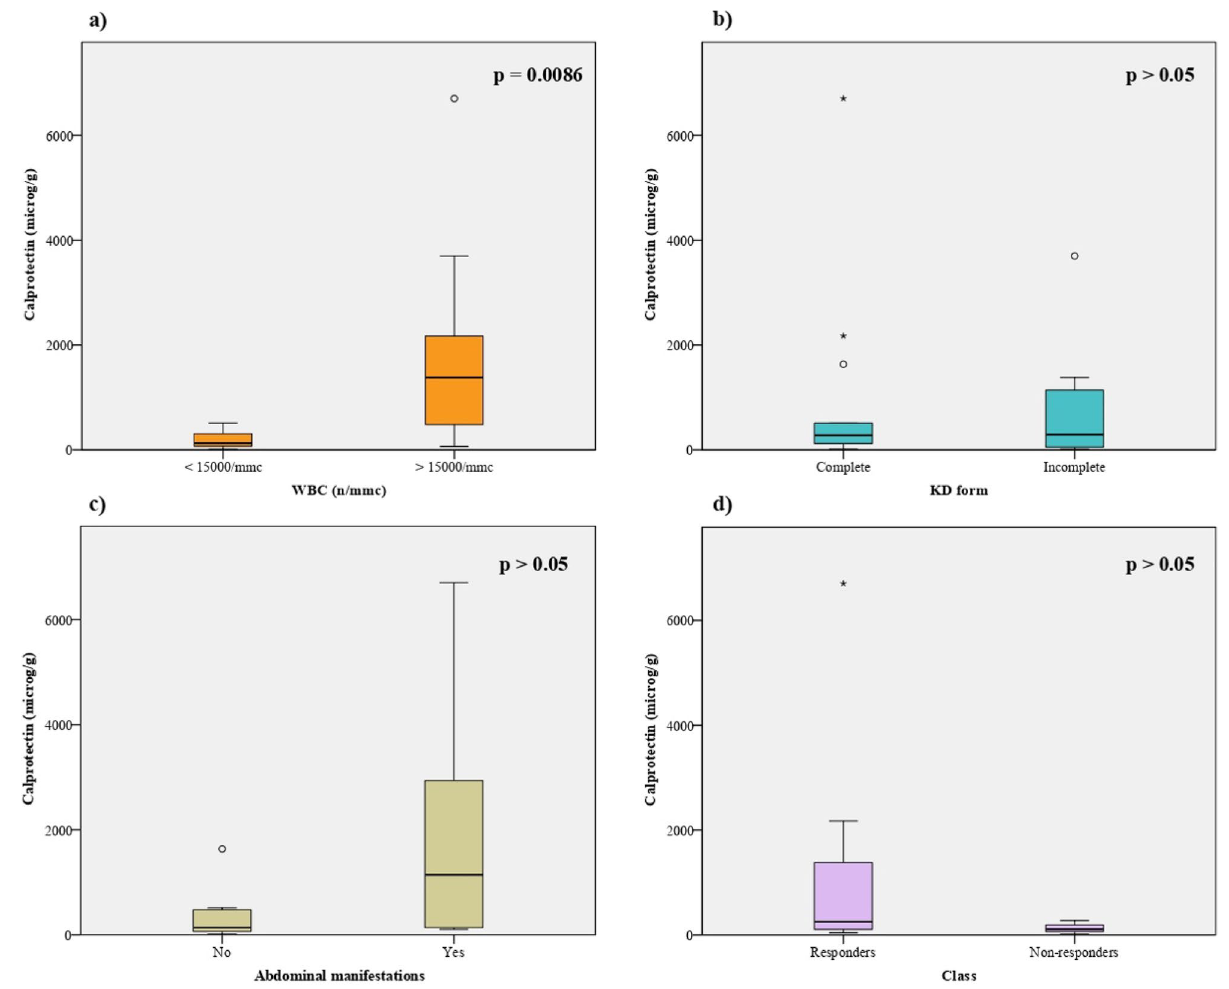
Figure 1. Comparison of FC concentration in patients with WBC > 15,000/mmc vs those with WBC < 15,000/ mmc ( a ), in patients with abdominal manifestations vs those without ( b ), in IVIG-responders vs IVIG non- responders ( c ) and in patients with complete vs those with incomplete form ( d ). Software: SPSS Statistics